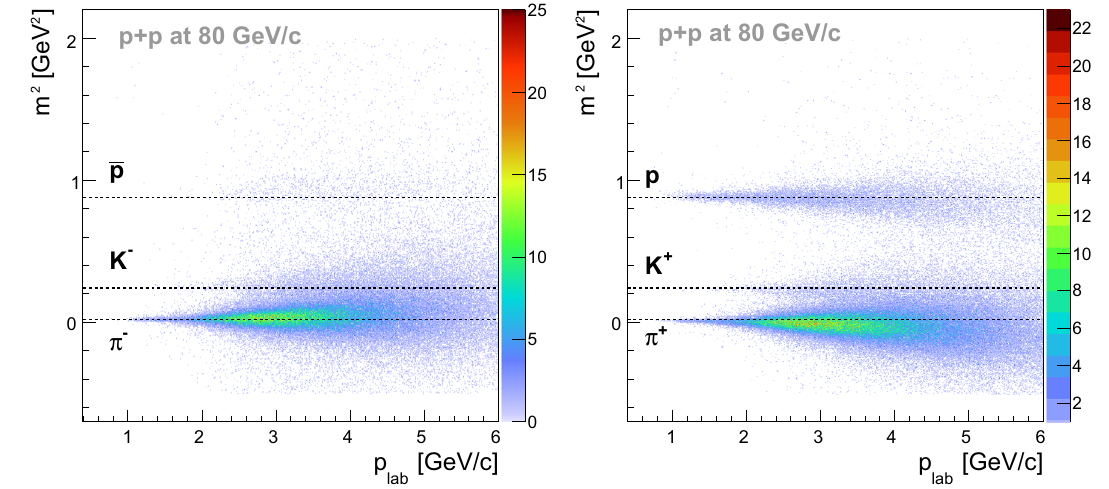
Fig. 7 Mass squared versus momentum measured by ToF-R ( left ) and ToF-L ( right ) detectors for particles produced in p + p interactions at 80 GeV / c . The lines show the expected mass squared values for different hadrons Fig. 8 Particle number distribution in the m 2 -d E / d x plane for negatively ( left ) and positively ( right ) hadrons with momenta close to 4 GeV / c for p + p interactions at 40 GeV / c . Electrons are not visible since their d E / d x values are beyond the d E / d x plot